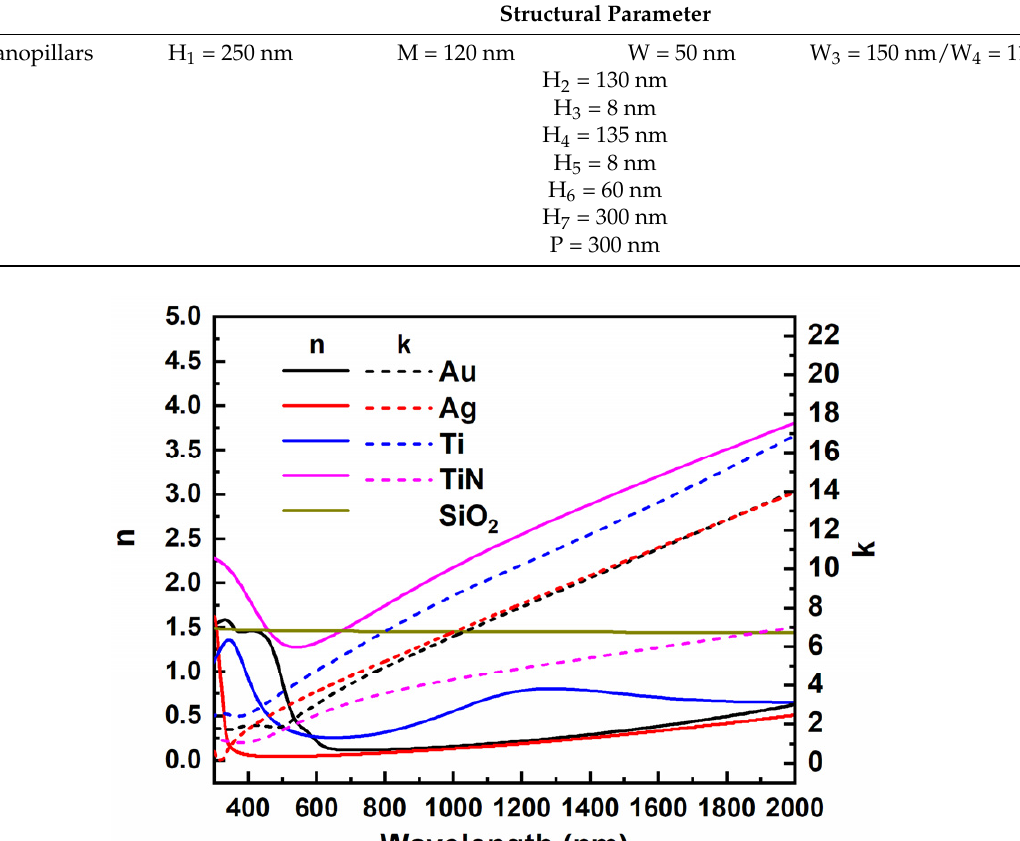
sorber. ( c ) Lateral view of the absorber.